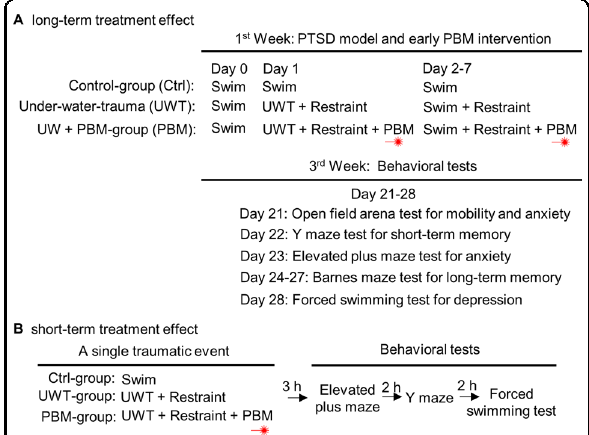
Fig. 1 Experiment design paradigm. A UWT-group rats were restrained immediately following UWT at day 1. From day 2 to day 7, rats were allowed to swim for 1 min/day as a reminder session. Rats were immediately restrained (2 min) following UWT and swimming sessions. During restraint, rats who received PBM treatment (2 min) were assigned as PBM-group, and rats that did not receive PBM treatment were assigned as UWT-group. In total, each PBM-group rat received 7 doses of PBM treatment. Ctrl-group rats were allowed to swim freely from day 0 to day 7. All rats remained undisturbed during days 8 – 20. A battery of behavioral tests was performed, beginning on day 21. B Rats underwent the same UWT event and PBM treatment as the above experimental design on day 1. Three hours later, a battery of behavioral tests for PTSD-like comorbidities was